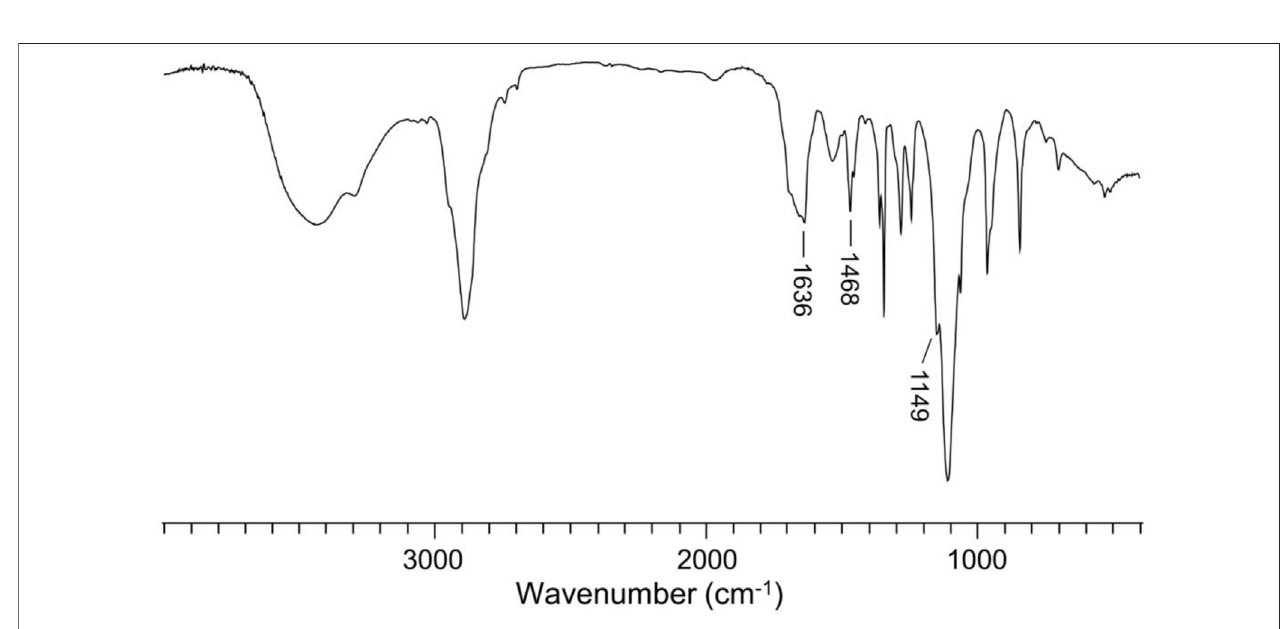
FIGURE 2 | FT-IR result of mPEG − P(LP- co -LC).